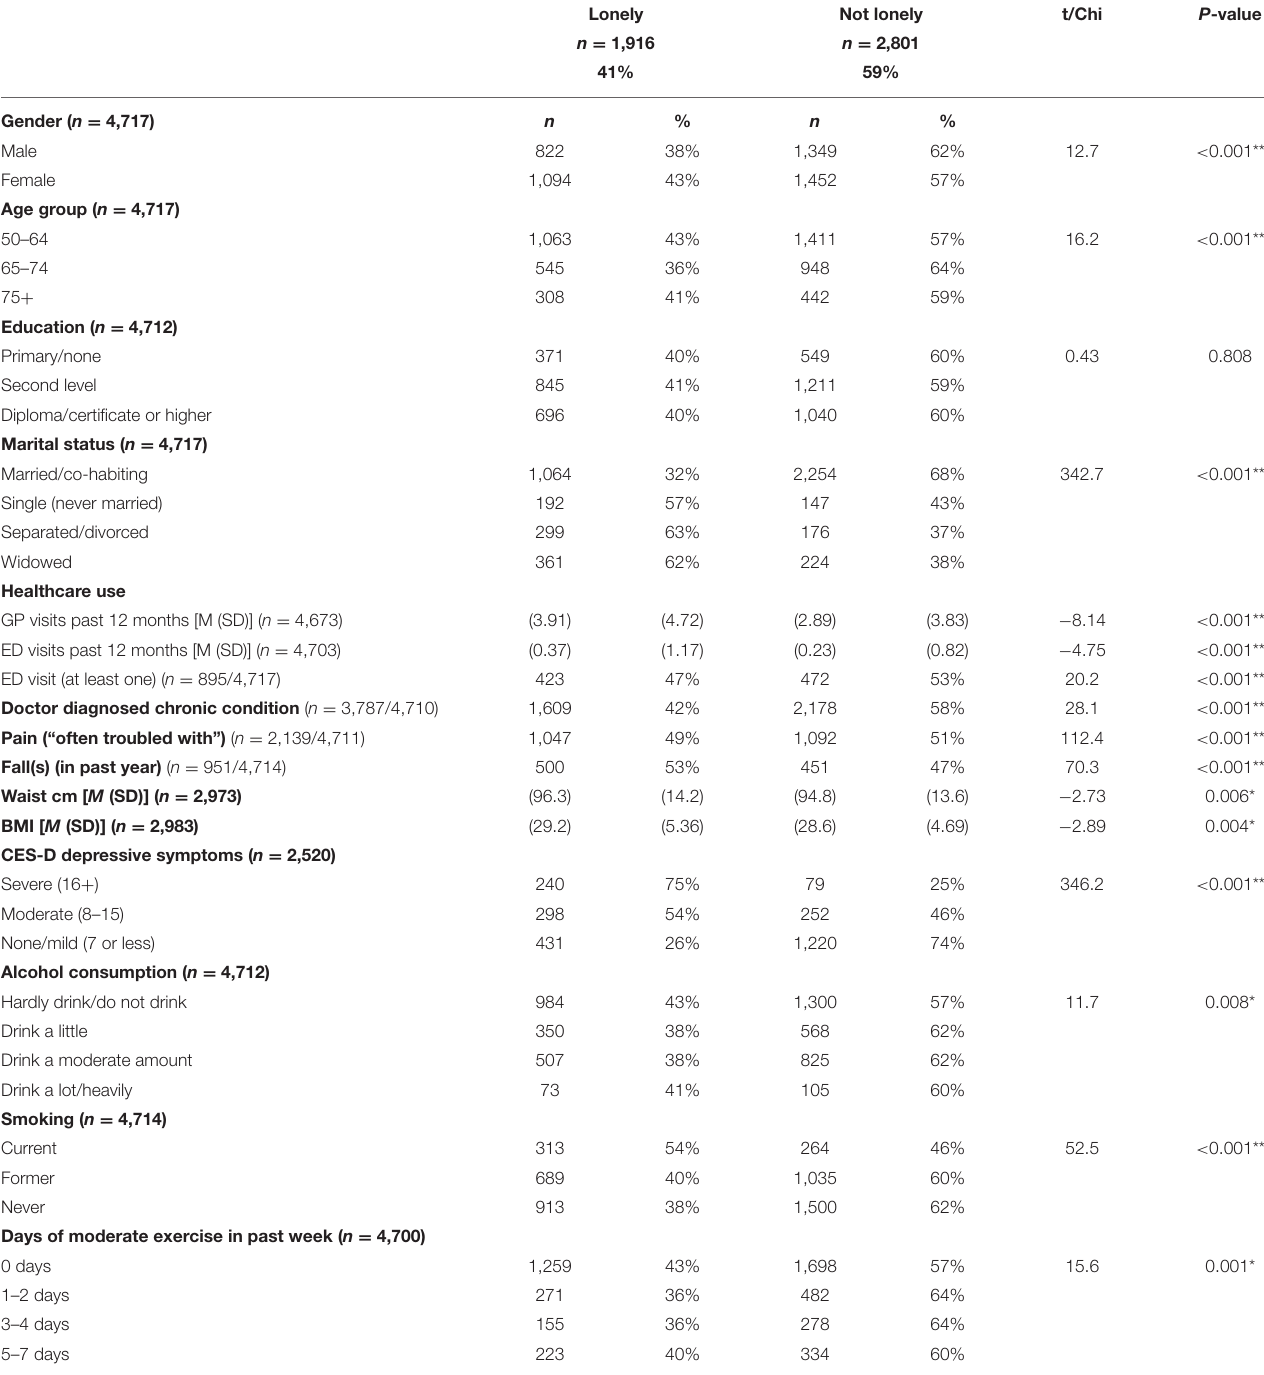
TABLE 1 | Demographics, health and HCU characteristics of NICOLA cohort by Loneliness (Threshold variable based on items 1-3) ( N = 4,717). Lonely Not lonely t/Chi P